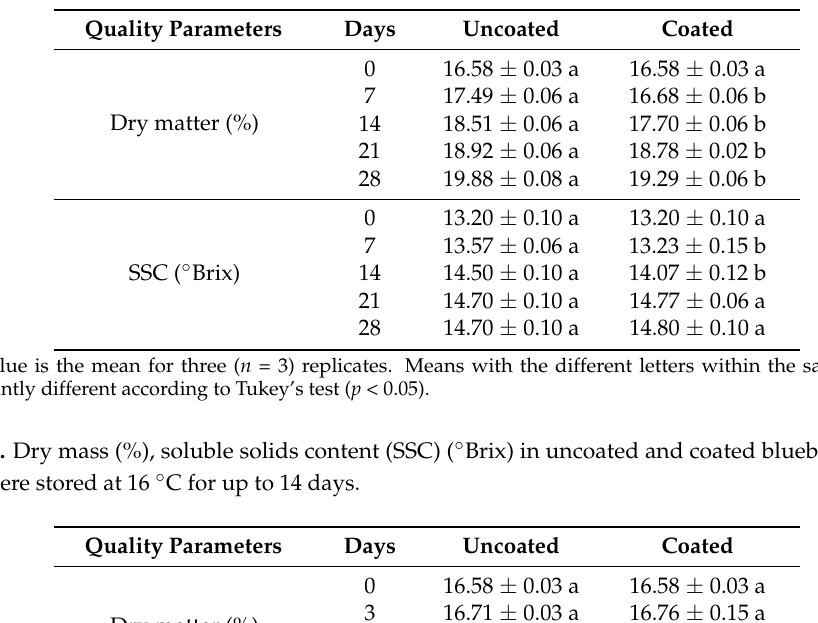
Table 1. Dry matter (%), soluble solids content (SSC) ( ◦ Brix) in uncoated and coated blueberries fruit. Fruit were stored at 4 ◦ C for up to 28 days.